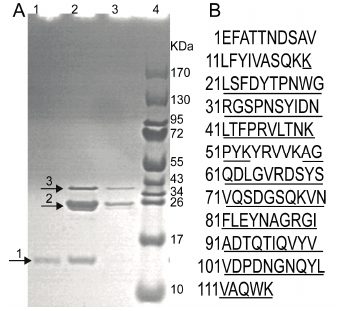
Figure 1. Purification and identification of rFIP-nha. ( A ) Tricine-SDS-PAGE analysis. GST-FIP-nha was purified using a GST column, digested with thrombin and eluted with PBS and glutathione. Lane 1: Eluate with PBS. Lanes 2 and 3: Eluates with glutathione. Lane 4: Standard protein molecular weight markers. Arrows 1, 2, and 3 indicated the purified rFIP-nha, GST, and GST-FIP-nha, respectively; ( B ) Amino acid sequence of deduced FIP-nha. Nine peptide fragments consisting of 91 residues identified by MALDI-MS are